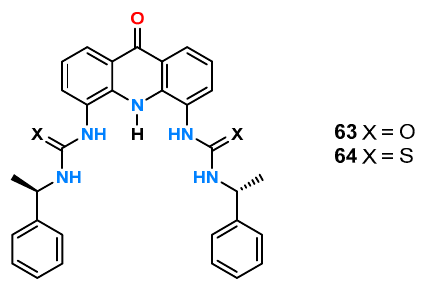
Figure 20. Receptors 63 and 64 using the acridinium-9-one platform.